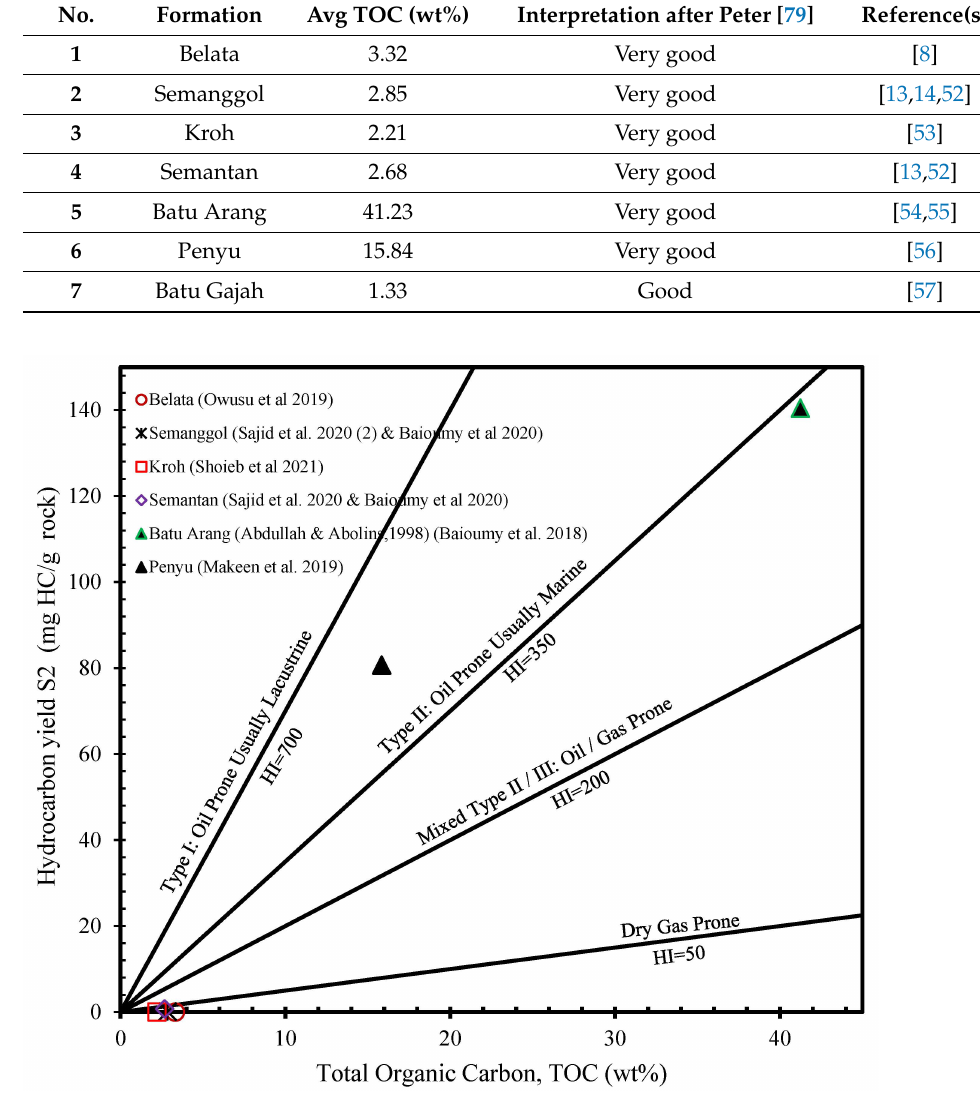
Figure 4. A plot of average S2 versus average TOC of formations in Peninsular Malaysia showing hydrocarbon yield potential and type of